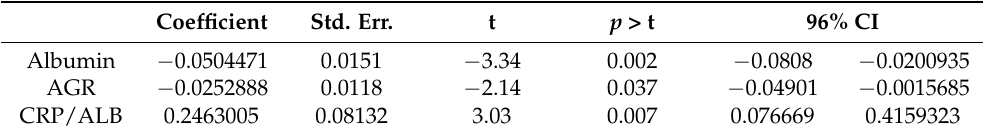
Table 3. Results of the robust regression studying the relationship between serum concentrations of albumin, AGR and CRP/ALB and the CCECAI score before endoscopic procedure